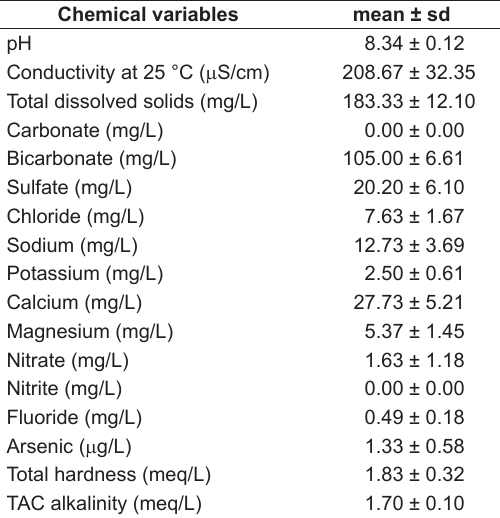
Figure 2. Total precipitation values (mm) during the study period. The abbreviations Ap, Ju, Au, Oc, De and Fe correspond to the months. Ap: April, Ju: June, Au: August, Oc: October, De: December, Fe: February. The number 7 indicates year 2007, and the number 8, indicates year 2008. Table 2. Water chemical composition of Achiras stream during the period